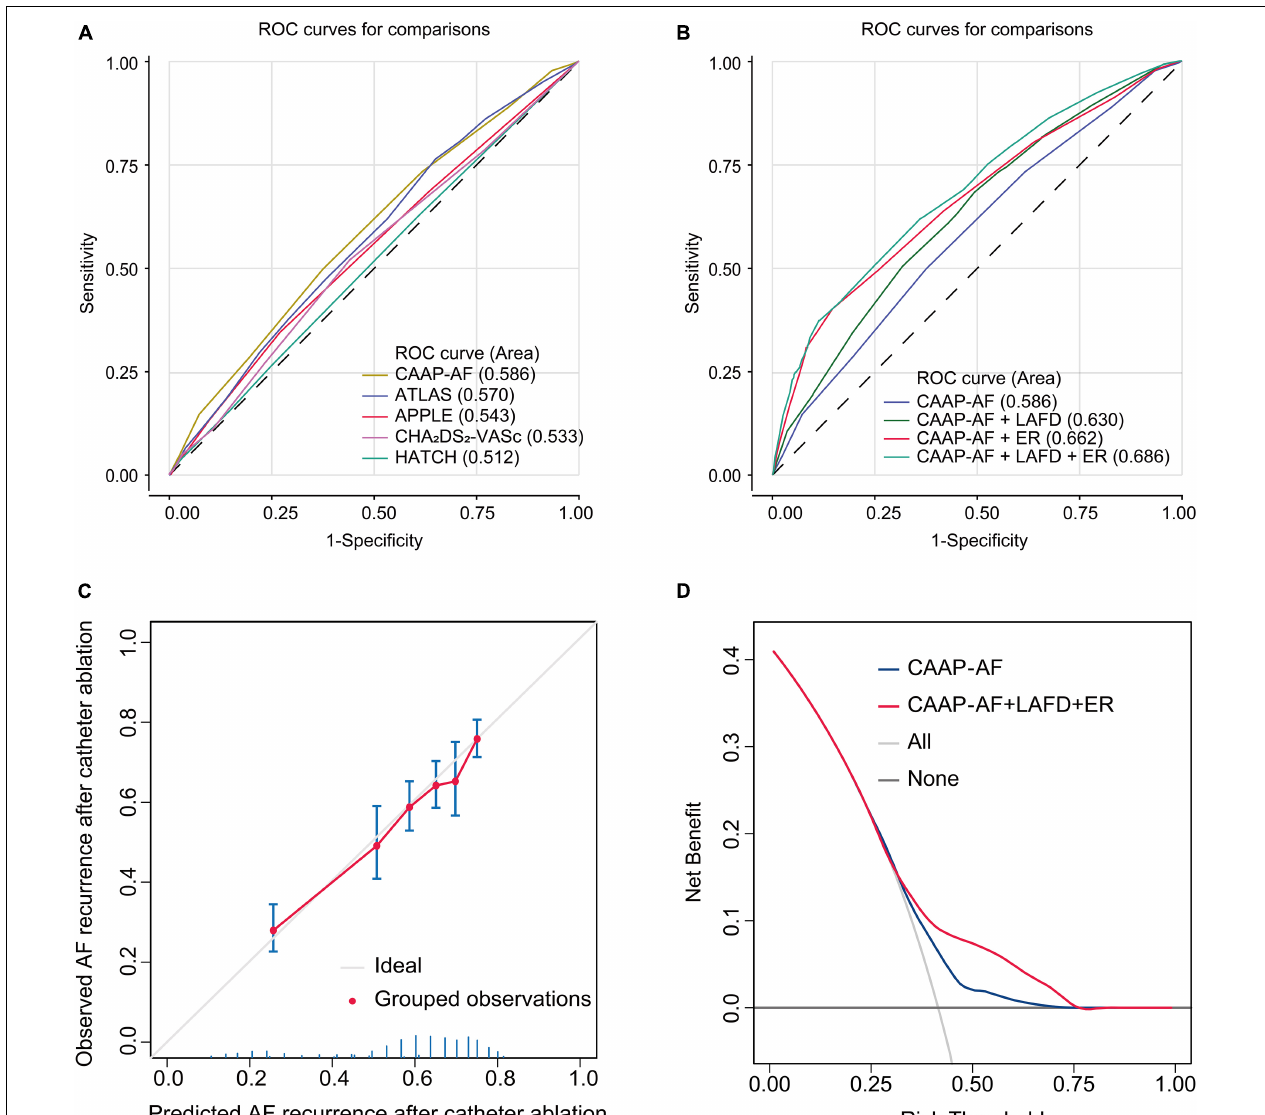
FIGURE 4 | Model-comparison results of predicting the 5-year incidence of recurrence. (A) Receiver operating characteristics (ROC) curves of freedom from recurrence at 5 years for the different risk prediction models recommended by the guideline. (B) ROC curves of freedom from recurrence at 5 years for the CAAP-AF model and combined model. (C) Validation of the final model (CAAP-AF model + LAFD + ER) showing observed incidences of recurrence within 5 years. The diagonal gray line represents a situation of perfect prediction when the observed incidences would be identical to the predicted baseline risks. Points are drawn to represent the averages in six discretized bins, and error bars are 95% CIs for the proportion of events in each group. The rug under the plot illustrates the distribution of predictions. (D) Decision curve analyses (DCAs) of the CAAP-AF model and final model for 5-year recurrence incidence. The x-axis indicates the threshold incidence for recurrence at 5 years and the y-axis indicates the net benefit. The horizontal dark gray line: to assume no patients will experience the event; the light gray line: to assume all patients will experience the event. The final model had enhanced net benefit compared with the CAAP-AF model at a threshold probability of